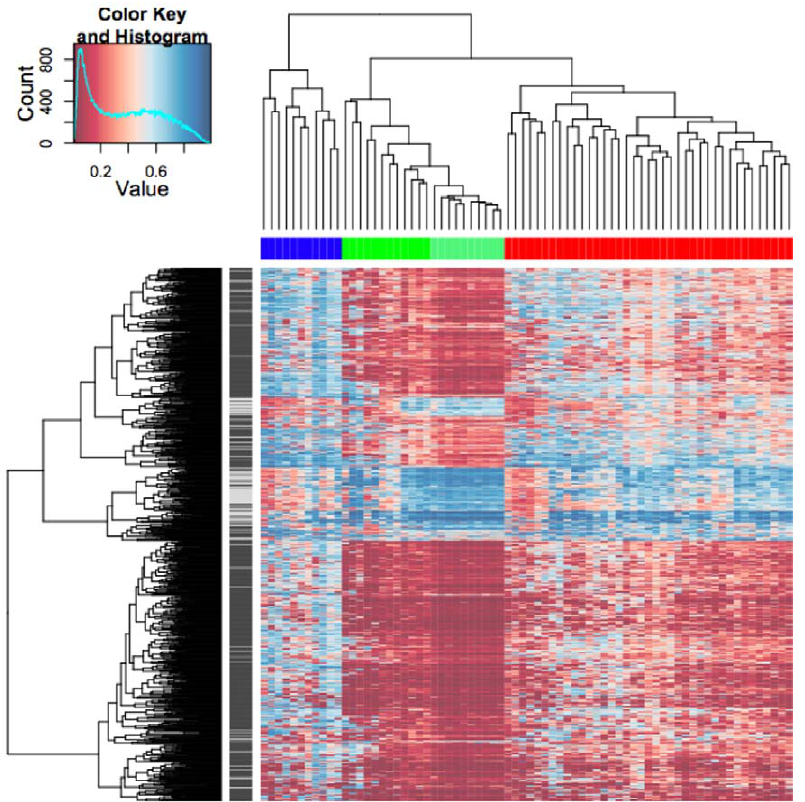
Figure 1. Hierarchical clustering of methylation values ( b ) from 1,000 CpG loci from 62 breast tumor and 10 normal breast tissue samples. Columns represent samples; rows represent CpG loci. Color represents methylation level b from 0 to 1 as per color bar (red = low methylation level; blue = high methylation level). Vertical color bar indicates location of CpG locus within the CpG island (dark grey) or outside of CpG island (grey). Top horizontal color bar indicates sample cluster. Samples separated into three distinct groups: a group consisting of 11 tumor samples (blue), a group consisting of 39 tumor samples (red) and a group including all normal breast tissue samples (light green) and 12 tumor samples (dark green).